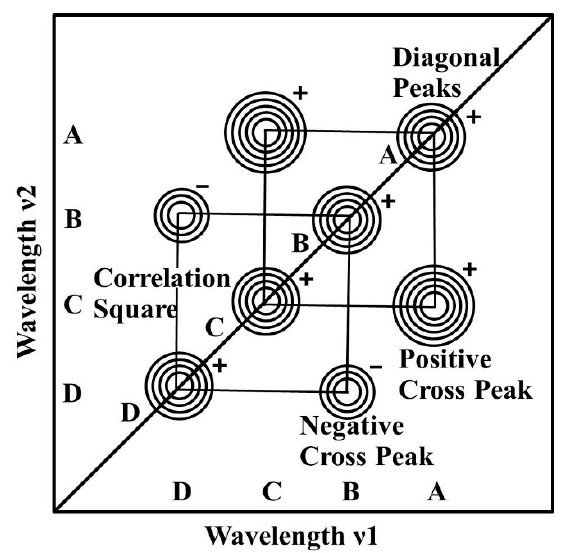
Figure 1. Outline the functionality and symbolic presentation of typical end results of the synchronous two-dimensional correlation spectroscopy (2D-COS).